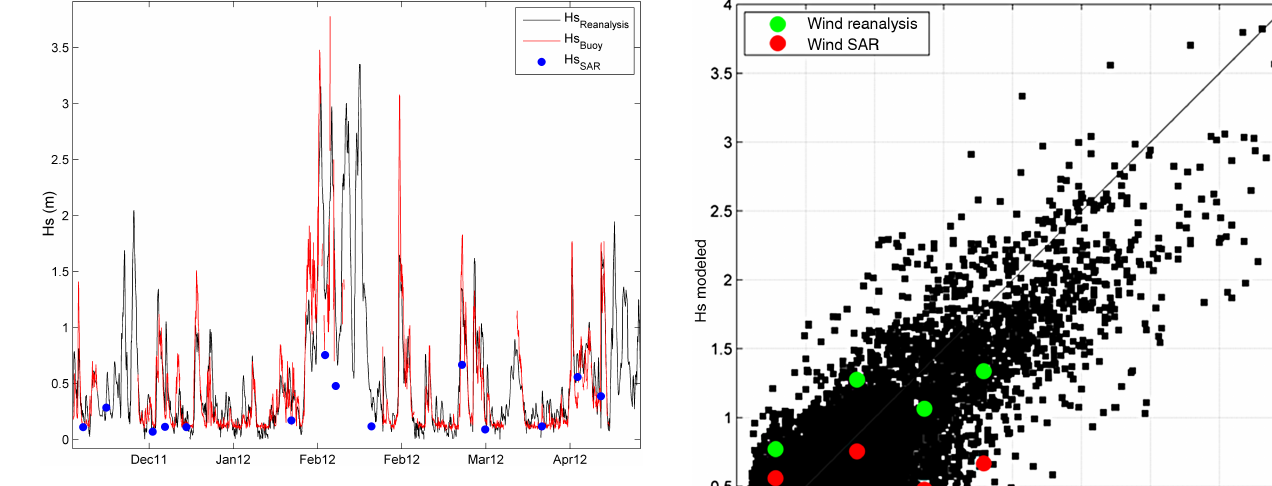
Figure 8. Comparison between the downscaled wave height series and the buoy wave height.